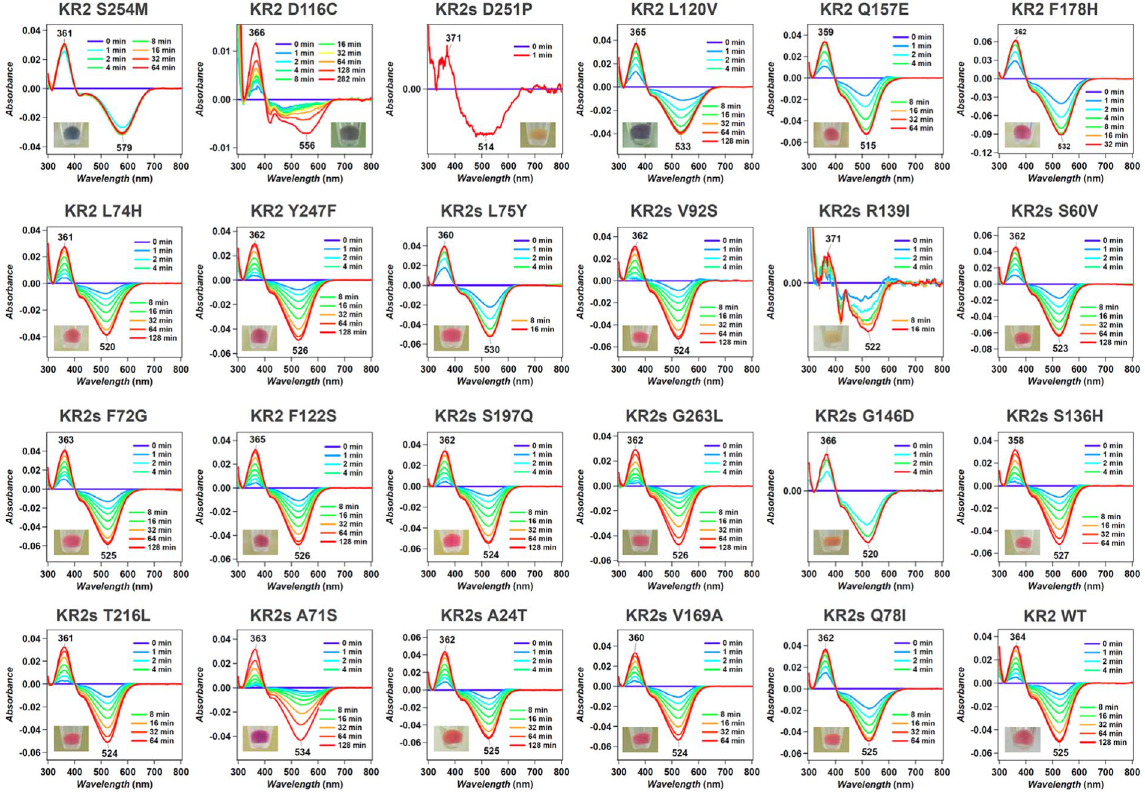
Figure 9. The difference spectra after and before the bleaching by hydroxylamine in 100 mM NaCl, 50 mM phosphate (pH 7.0), 2% DDM for KR2 mutants for which large red shift of the absorption was expected by ML. The times after the addition of hydroxylamine are shown in each